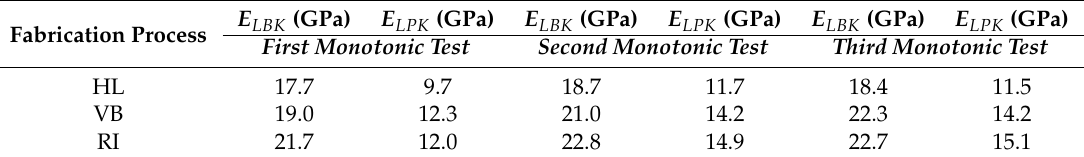
Table 3. Comparison of Young’s modules in the quasilinear regions before and after the knee.